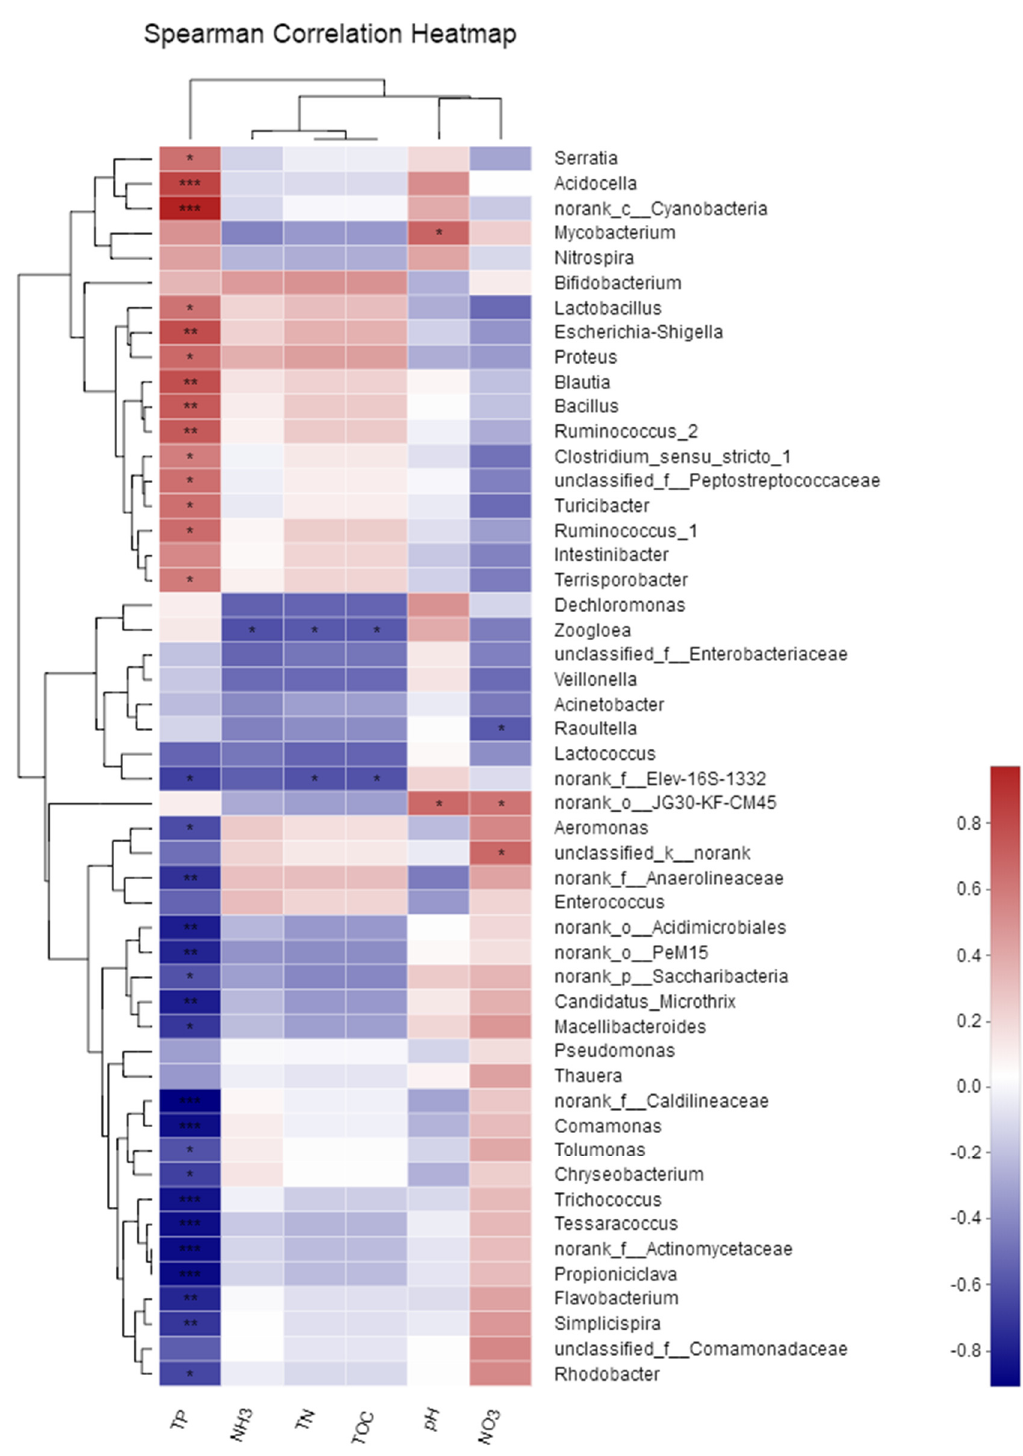
Figure 6. Spearman’s rank correlation studies on physicochemical properties and bacterial species abundances. The correlation coefficient is the heat map’s corresponding value, where the value of “r” ranges from − 1 to 1; r < 0 indicates a negative correlation, while r > 0 indicates a positive correlation. * means the test was significant at 0.01 < p ≤ 0.05, ** means the test was significant at 0.001 < p ≤ 0.01, *** means the test was significant at p ≤ 0.001.